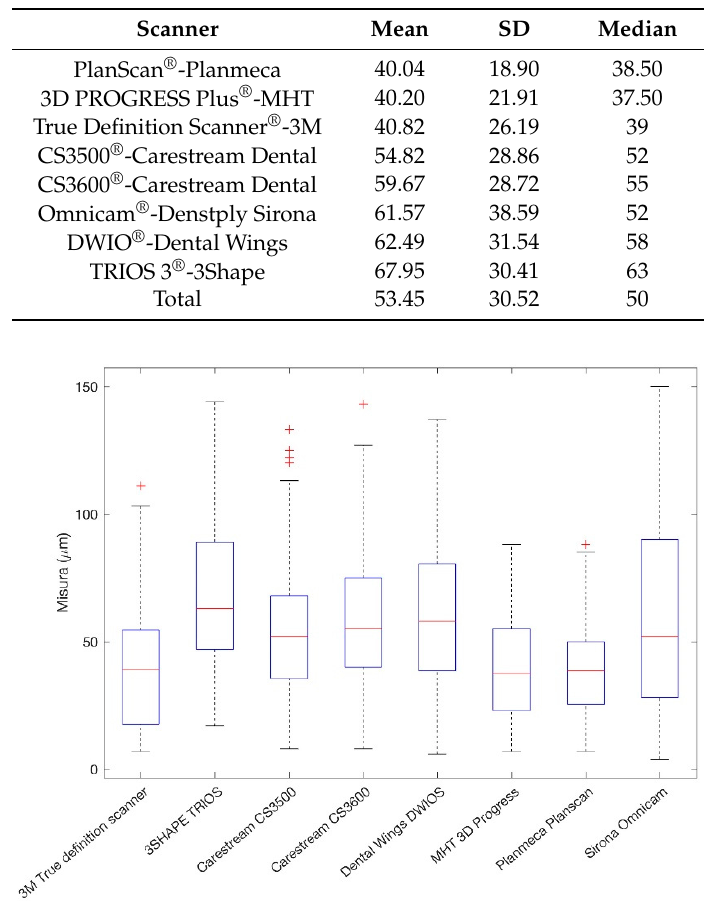
Table 1. Mean, standard deviation and median of the marginal gap values measured at abutment — coping interface of the eight groups. Omnicam ® (Denstply Sirona, Verona, Italy) CS3500 ® , CS3600 ® , (Carestream Dental, Atlanta, GA, USA), True Definition Scanner ® (3M, St. Paul, MN, USA), DWIO ® (Dental Wings, Montreal, Quebec, Canada), PlanScan ® (Planmeca Oy, Helsinki, Finland), 3D